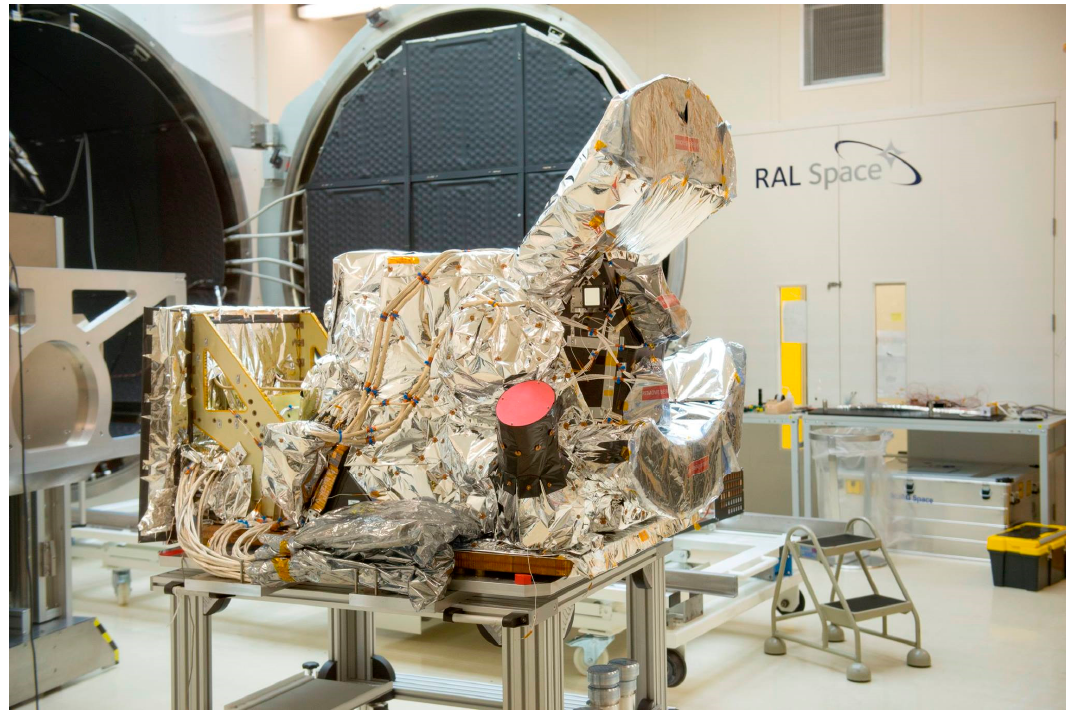
Figure 1. The Sea and Land Surface Temperature Radiometers (SLSTR)-B Instrument in the Space Test Chamber (STC) clean room at RAL Space under preparation for the infrared radiometric calibration tests.